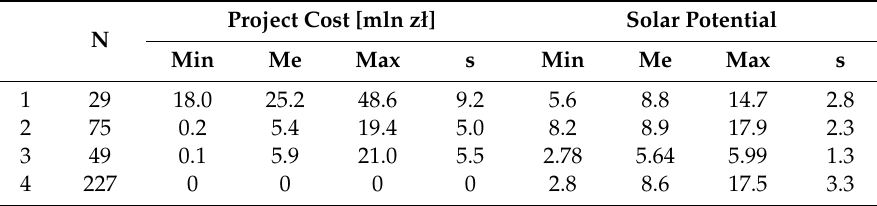
Table 2. Descriptive statistics for solar energy clusters.